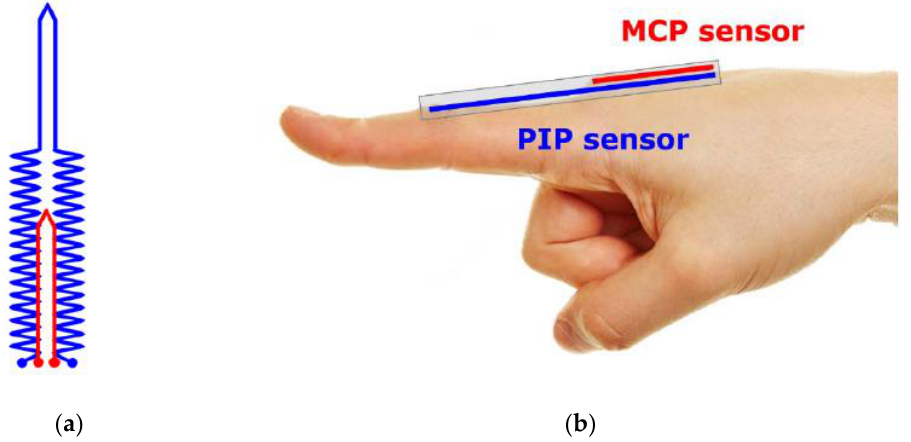
Figure 2. ( a ) Top view of the two-layer sensor design, ( b ) the placement of the sensor to measure the bending of the PIP and MCP joints.